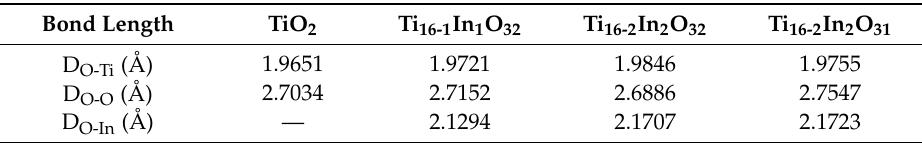
Table 1. Bond lengths (averaged) of the simulated